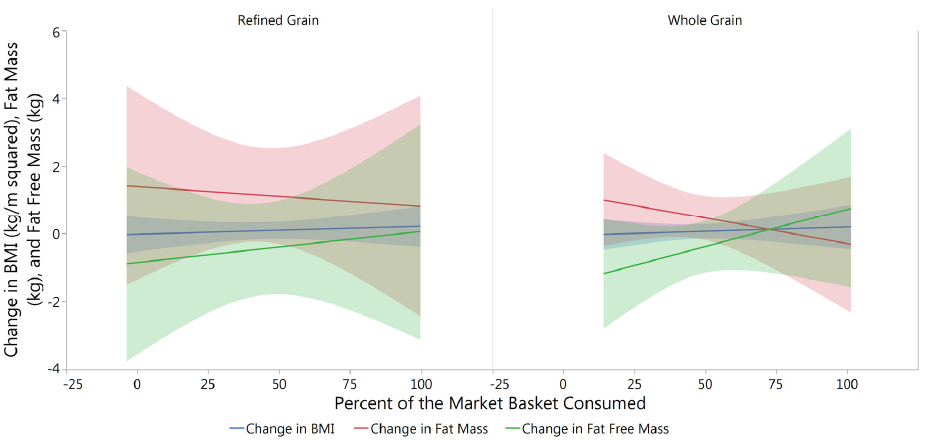
Figure 2. Changes in Body Composition with Percent Consumption of the Market Baskets. No significant differences were found using analysis of variance in the change of BMI (RG p = 0.494, WG p = 0.658), fat mass (RG p = 0.962, WG p = 0.372), or fat free mass (RG p = 0.823, WG p = 0.561) from baseline to post intervention.